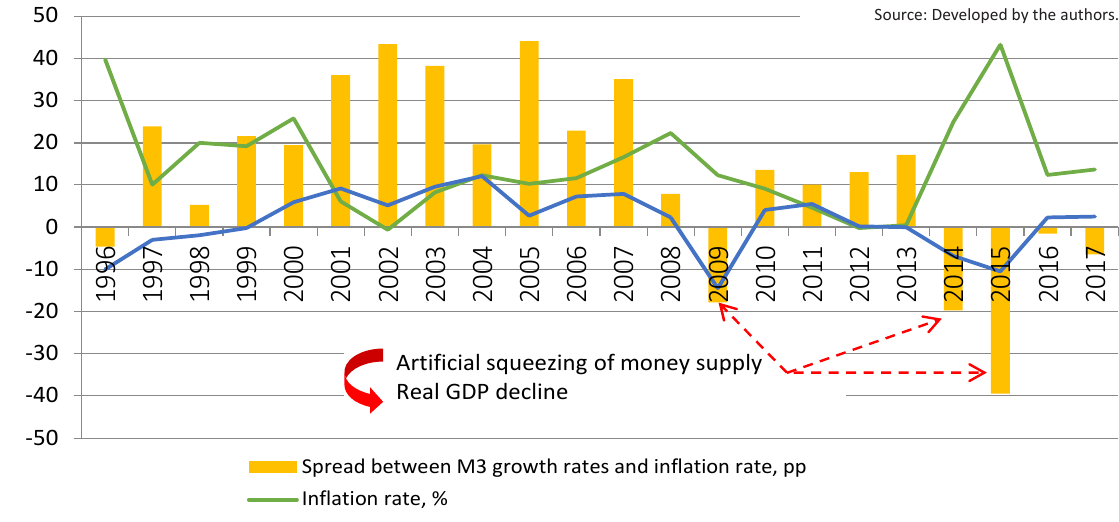
Figure 3. Dynamics of the inflation rate, real GDP growth rate and the spread between the M3 growth rates and inflation rate in Ukraine in